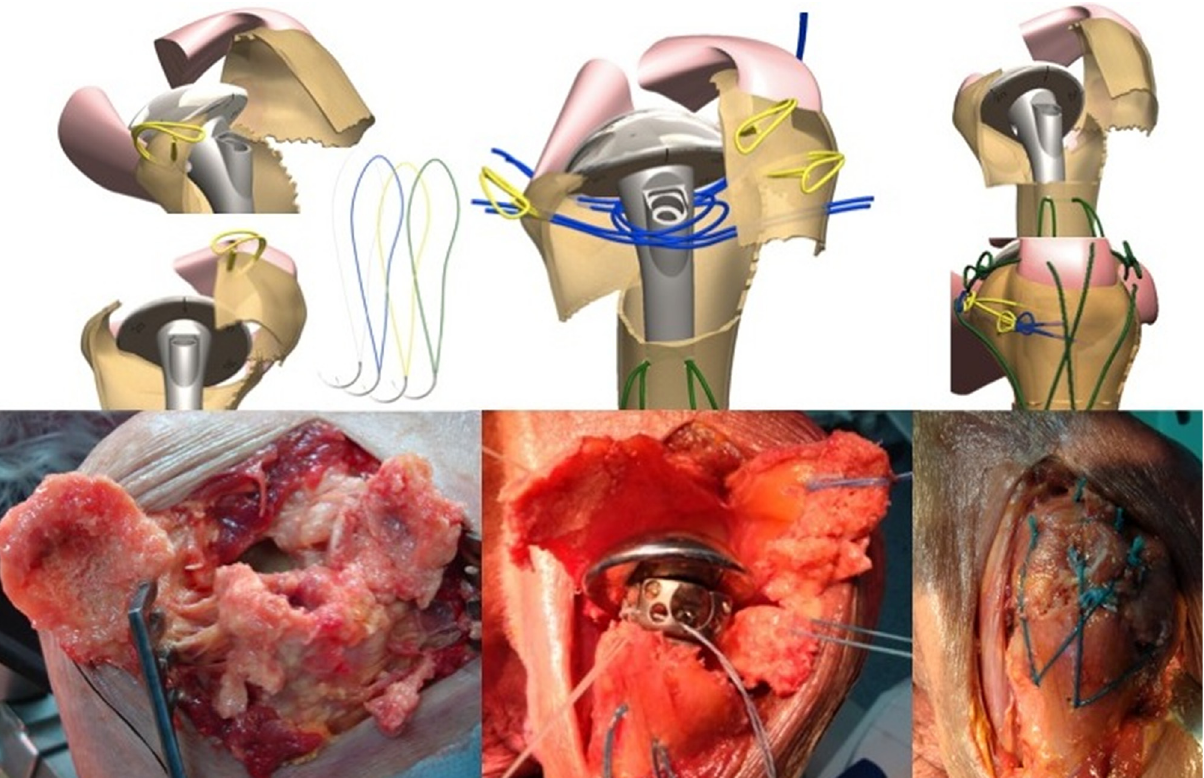
Figure 2. Looped thread system from left to right: The first to anchor and draw the tuberosities (in yellow), the next to press them to the implant passing through a hole designed for this (in blue), and the final group of two looped threads to create a vertical tie-down system (in green).